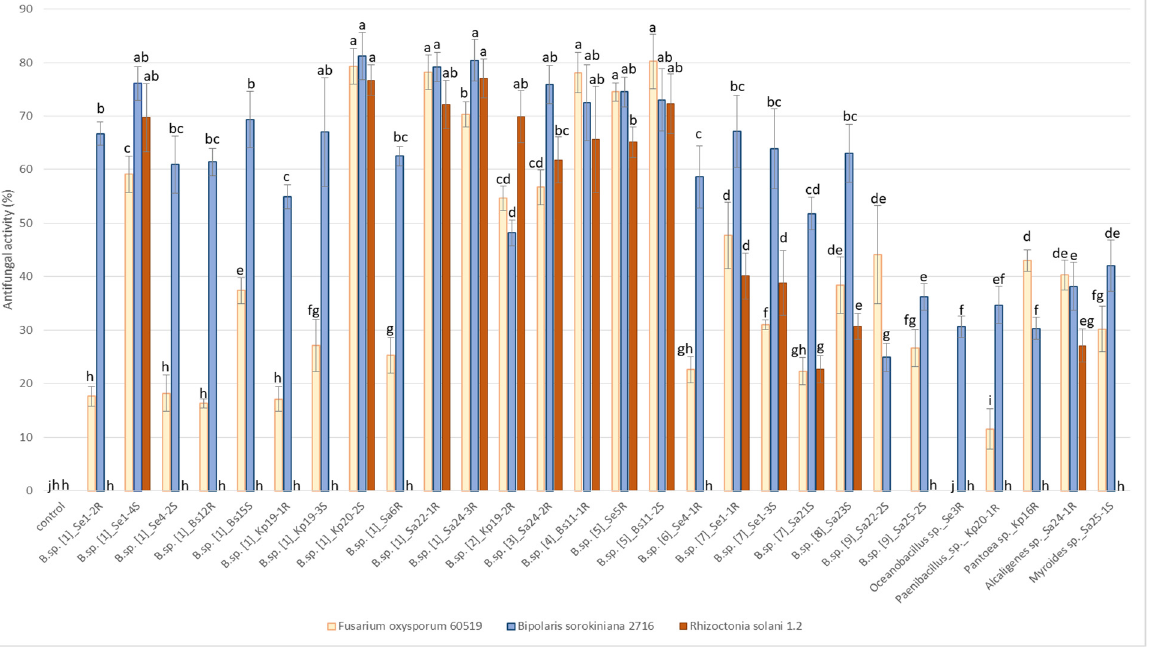
Figure 5. Antifungal activities (%) of endophytes against phytopathogenic fungi Fusarium oxysporum 60519, Bipolaris sorokiniana 2716, Rhizoctonia solani 1.2. Bars represent the mean ± SD of three different experiments, and different letters show a significant difference at the p ≤ 0.05 level, as determined by Duncan’s multiple